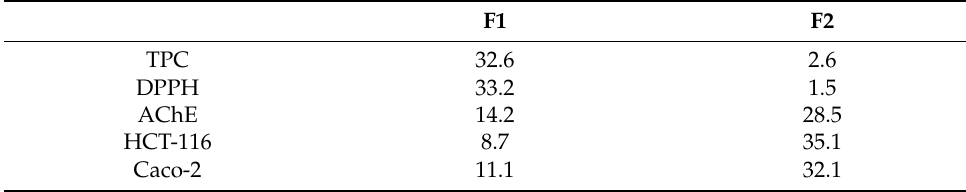
Table 5. Contribution of variable factors to the principal component analysis (%).